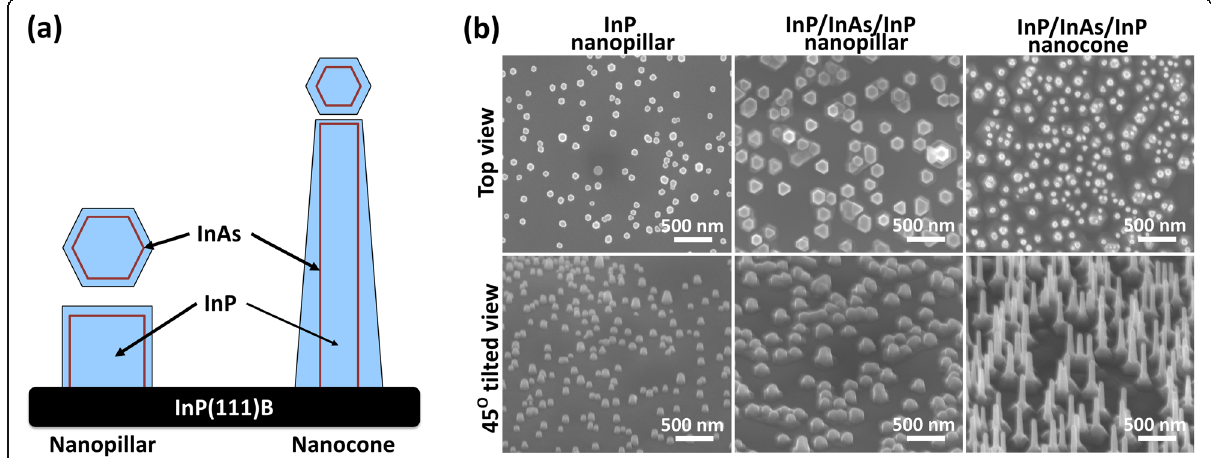
Fig. 1 Growth morphology of InP/InAs nanostructures. a Schematic layout of InP/In(As,P) multi core-shell nanopillar and nanocone. b SEM images of top view (upper row) and 45-degree tilted view (lower row) of InP nanopillars, InP/InAs/InP nanopillars, and InP/InAs/InP nanocones grown on (111)B oriented InP single crystal wafer